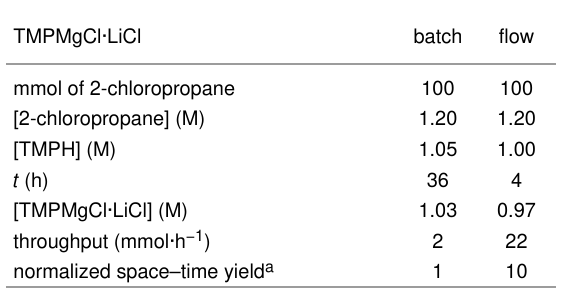
Table 5: Comparison between batch [47,67] and flow conditions for the synthesis of (TMPMgCl ⋅